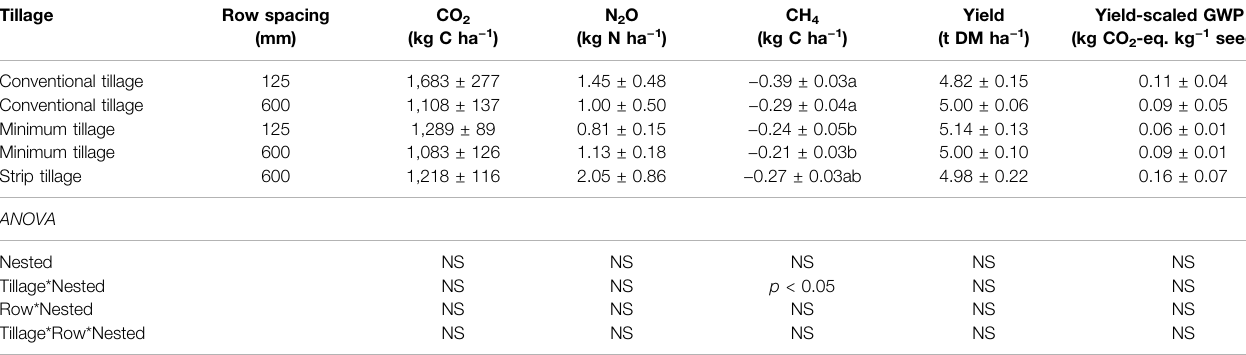
Different lowercase letters indicate signi fi cant variation between